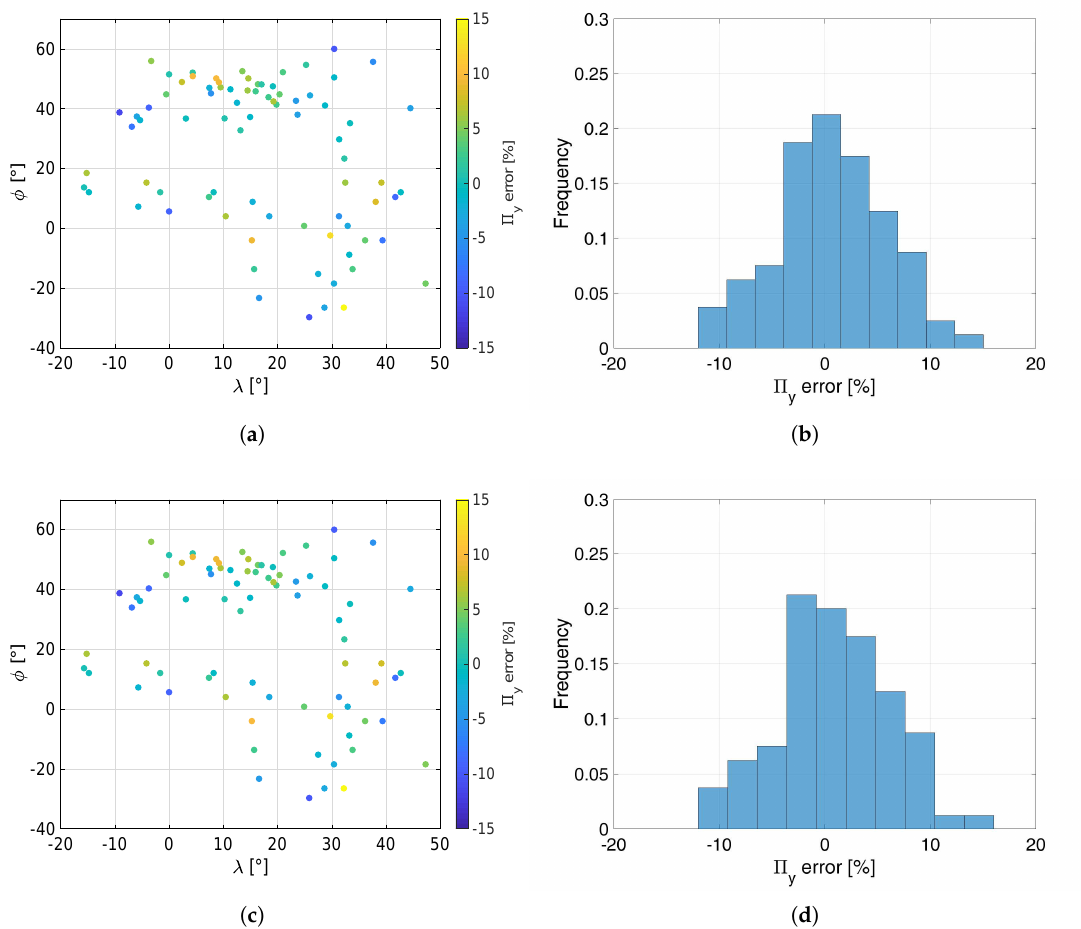
Figure 6. ( a ) Percent error between the current model predictions of Equation (6) and the values extracted from the PVGIS tool for the yearly electrical energy output ( Π y ) of FS PV systems over the 80 considered locations in Europe and Africa. Results are reported as a function of the latitude ( φ ) and longitude ( λ ), as well as in the form of ( b ) error distribution. ( c ) Percent error between the current model predictions and the values extracted from the PVGIS tool for the yearly electrical energy output of BI PV systems. Results are reported as function of latitude ( φ ) and longitude ( λ ), as well as in the form of ( d ) error